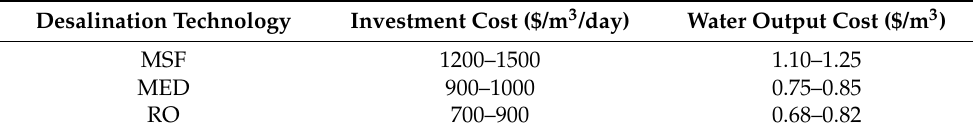
Table 3. Investment and water cost of major desalination technologies